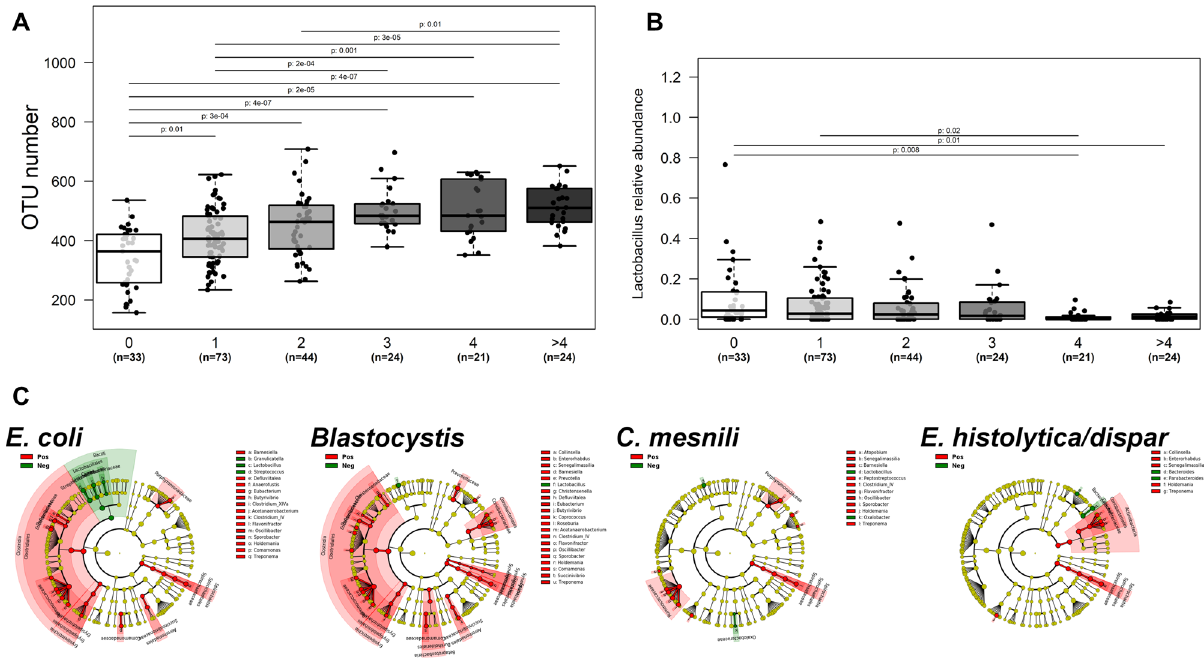
Figure 2. Association between intestinal colonization by parasites and the gut microbiome richness and composition. ( A ) Microbial richness (OTU number) as function of cumulative number of different protozoans detected in an individual (ranged from 0 to > 4). ( B ) Relative abundance of Lactobacillus genus as function of the cumulative number of protozoans detected in an individual (ranged from 0 to > 4). ( C ) Cladogram representation of bacterial groups significantly increased (in red) or decreased (in green) in the presence of the four main parasitic colonizers ( Entamoeba coli , Blastocystis sp., Chilomastix mesnili and Entamoeba histolytica / dispar